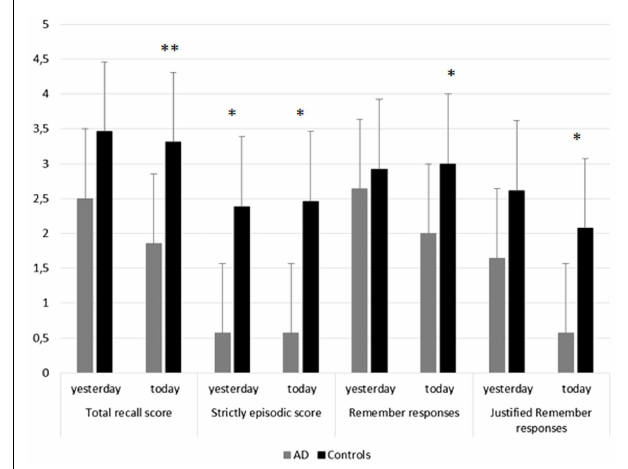
FIGURE 3 | Memory performance for yesterday and today events inAD patients and controls .This figure illustrates performance in AD patients and controls for each memory score (total recall score, strictly episodic recall score, number of Remember responses, number of justified Remember responses) for the recent period (P4), distinguishing yesterday, and today sub-periods. Stars indicate between group differences. * p < 0.05; ** p < 0.01.